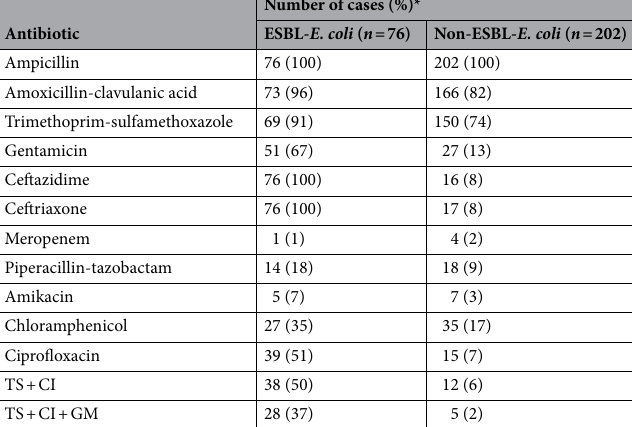
Table 3. Non-susceptibility against various antibiotics in ESBL-producing E. coli and in E. coli not producing ESBL, detected in feces in 278 E. coli isolates from 350 children at admission. *Percentage of non-susceptibility. TS trimethoprim-sulfamethoxazole, CI ciprofloxacin, GM gentamicin.